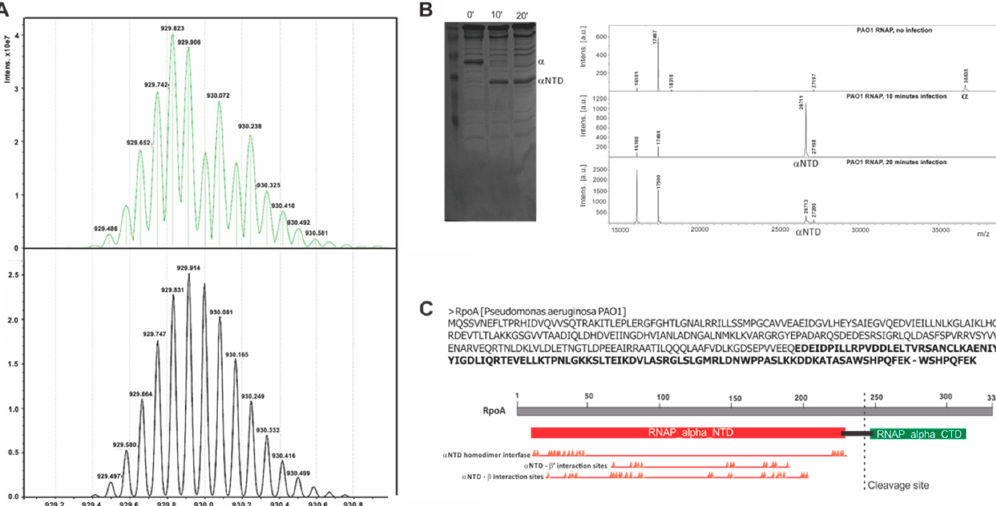
Figure A1. Determination of cleavage site within C-terminal domain ( α CTD). ( A ) The cleaved α CTD was purified from phage-infected cells using the C-terminally fused Strep II TM -tag (WSHPQFEK) and subjected to Fourier mass spectrometry (APEX-Qe, Bruker Daltonics). The protein mass (including the tag) was calculated from the spectrum (in green) to be 11,157.87 Da, corresponding to the RpoA fragment indicated in bold in the primary sequence. The bottom figure (in black) represents the theoretical spectrum of this α CTD fragment, with a predicted mass of 11,152.96 Da. The cleavage site is located in the flexible linker sequence connecting the two functional domains. ( B ) Alternative determination of cleavage site within the α CTD domain. The entire RNAP complex was purified from phage-infected cells, separated on SDS-PAGE (left panel) and subjected to MALDI-TOF mass spectrometry (right panel). The relevant m / z range is shown. After ten minutes of infection, we noticed the disappearance of the peak corresponding to the original α subunit (38,835 Da), while a single alternative peak at 26,712 ± 1 Da appeared. This mass allowed us to determine the cleavage site within the flexible linker. ( C ) The di ff erent domains of RpoA are shown with the exact position of the cleavage site.